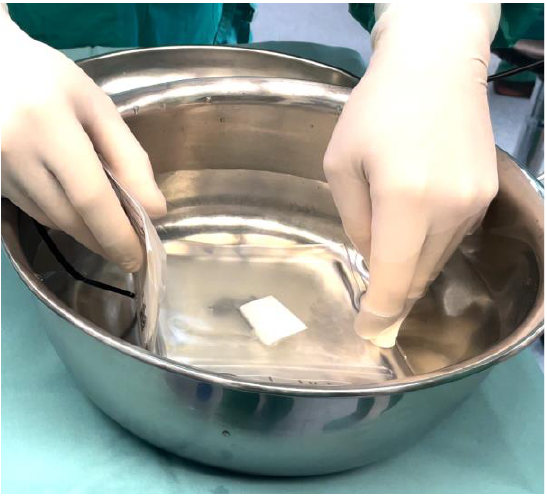
Figure 3. The cryopreserved hAM, placed on a filter, was thawed by immersion in a bath of saline solution at 40 °C.